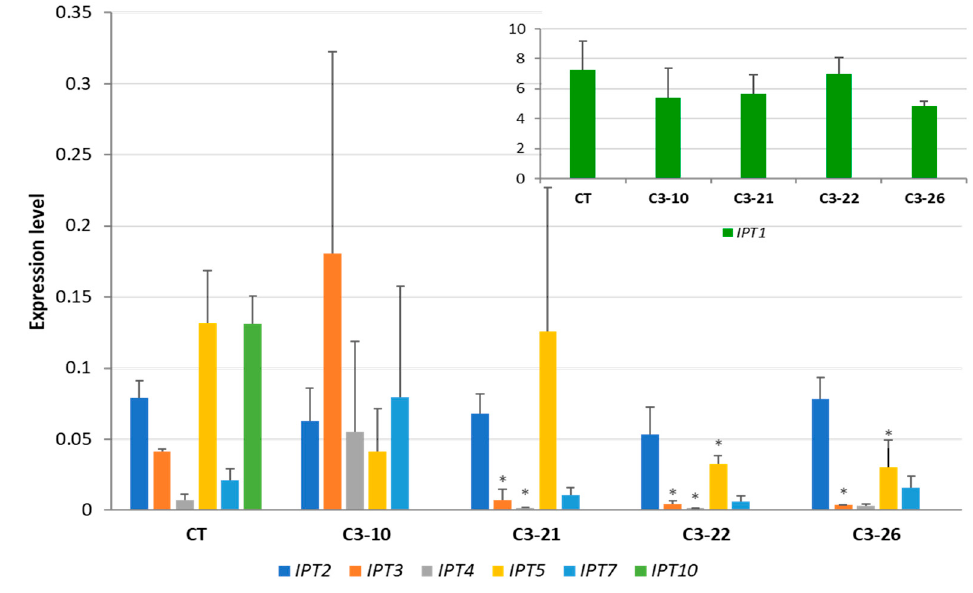
Figure 8. Expression levels of HvIPT genes in 10-day-old roots of ckx3 mutant lines; the expression of HvIPT1 was shown on a separate graph because of the higher expression level. CT, control plants; values are mean ± SD (Table S9) * significantly di ff erent from control at p < 0.05. The expression levels were calculated from three technical replicates according to the standard curve methods using the Elongation factor 2 gene as a normalizer. The analysis was performed for three biological